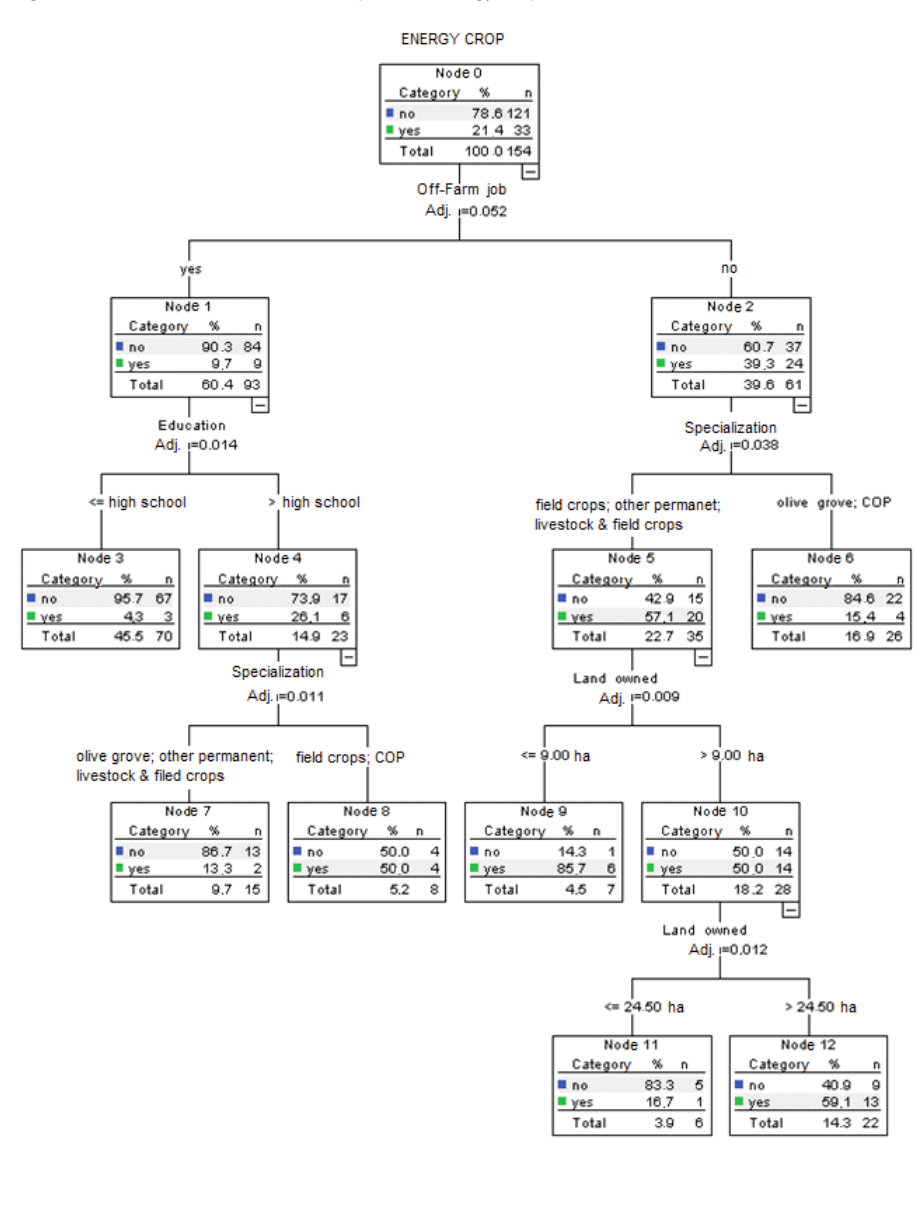
Figure 2. Classification tree for the adoption of energy crops